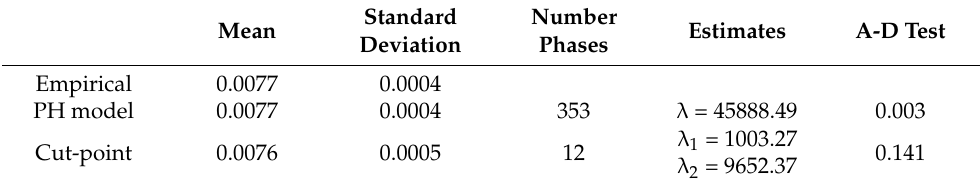
Table 2. Summary for the PH and one cut-points adjustment for the reset current.